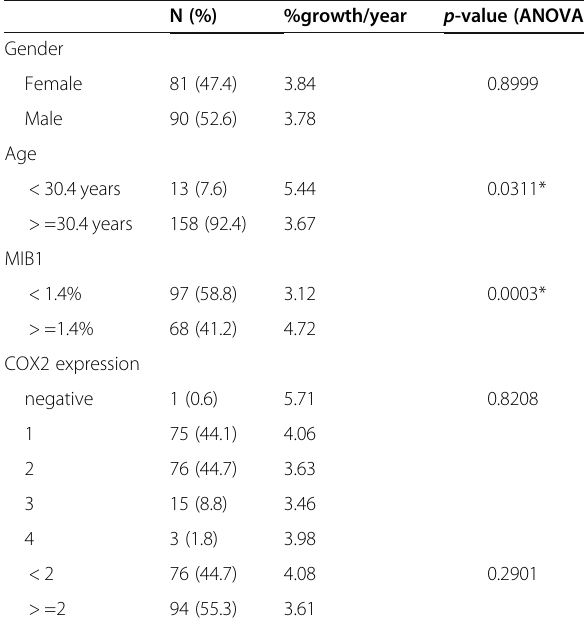
Table 2 Differences in volumetric